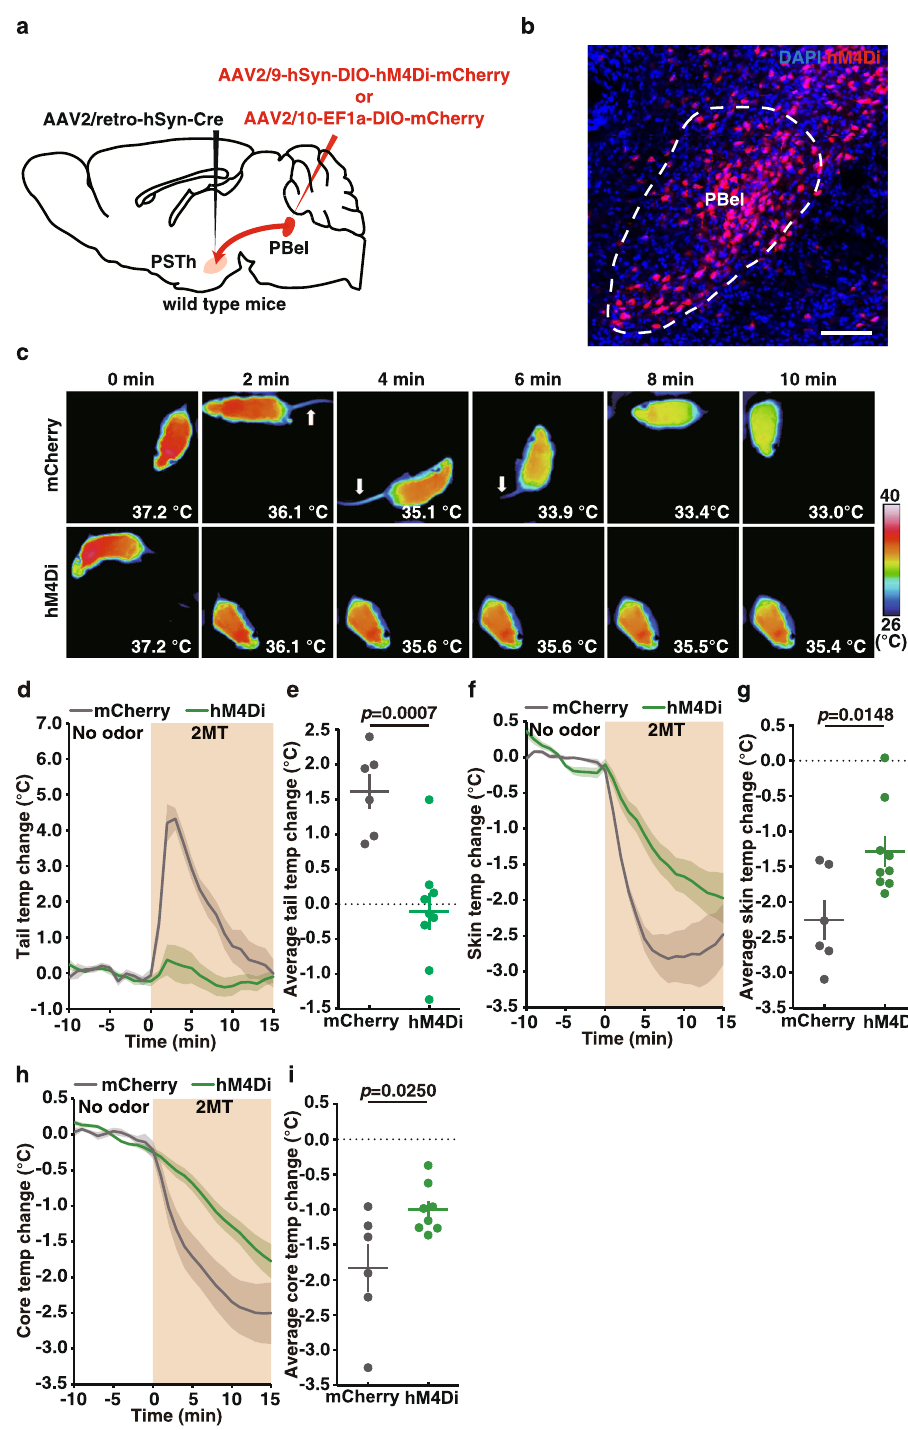
Fig. 7 Inhibition of PSTh-projecting PBel neurons diminishes 2MT-evoked hypothermia and tail temperature increase. a Schematic of chemogenetic inhibition PSTh-projecting PBel neurons. b Representative image of hMD4i-labeled PSTh-projecting PBel neurons ( n = 2). c Time-lapsed thermal images of mCherry-expressing mice and hM4Di-expressing mice during 2MT treatment following administration of C21. Tail ( d ), skin ( f ), and core ( h ) temperature curves of mice with (hM4Di, n = 8 or 9) or without (mCherry, n = 6) inactivation of PSTh-projecting PBel neurons before and during 2MT treatment. Average tail ( e ), skin ( g ), and core ( i ) temperature changes of mice with (hM4Di, n = 8 or 9) or without (mCherry, n = 6) inactivation of PSTh-projecting PBel neurons during 2MT treatment. d – i Data are mean ± SEM; two-side Student ’ s t test. Scale bar, 100 µ